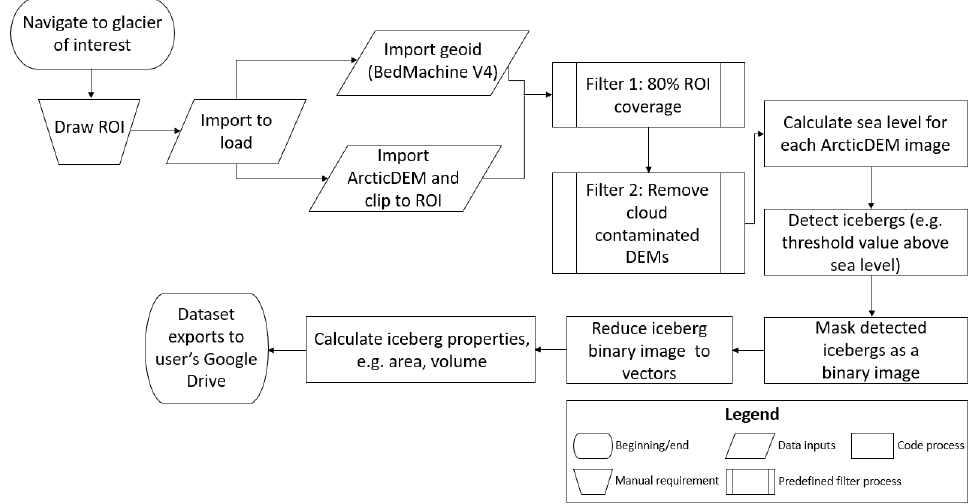
Figure 2. Workflow model of the automated iceberg detection in